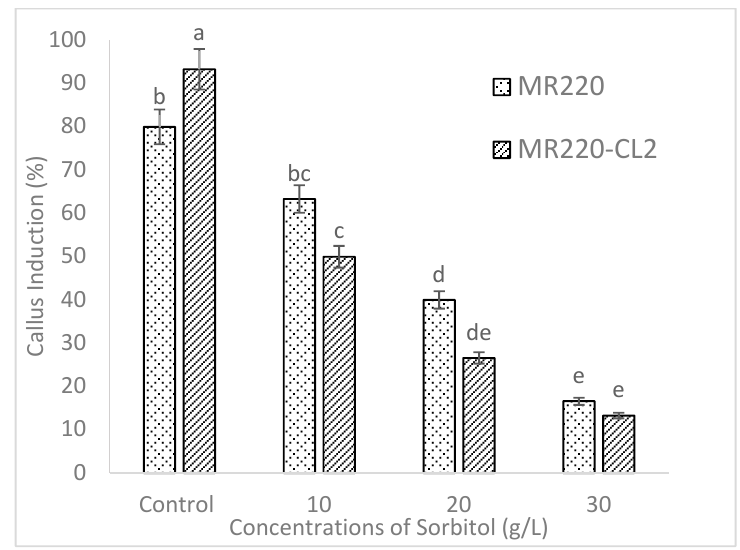
Figure 5. The callus induction of MR220 and MR220-CL2 on MS media with 30 g/L maltose, 3 mg/L of 2 and 4-D incorporated with different concentration of sorbitol. I represents standard error.